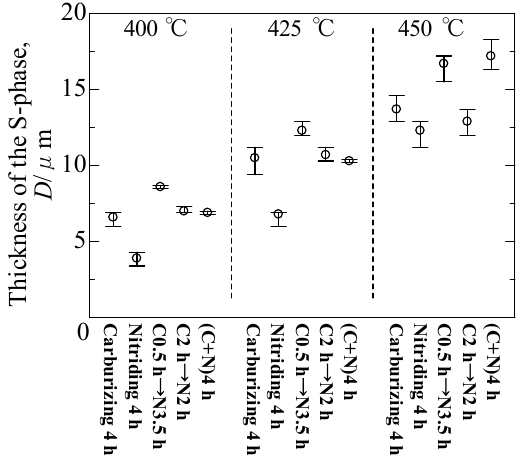
Figure 7. Thicknesses of the S-phase layers on cold-sprayed AISI 316L coatings subjected to various low-temperature plasma treatments at different temperatures.